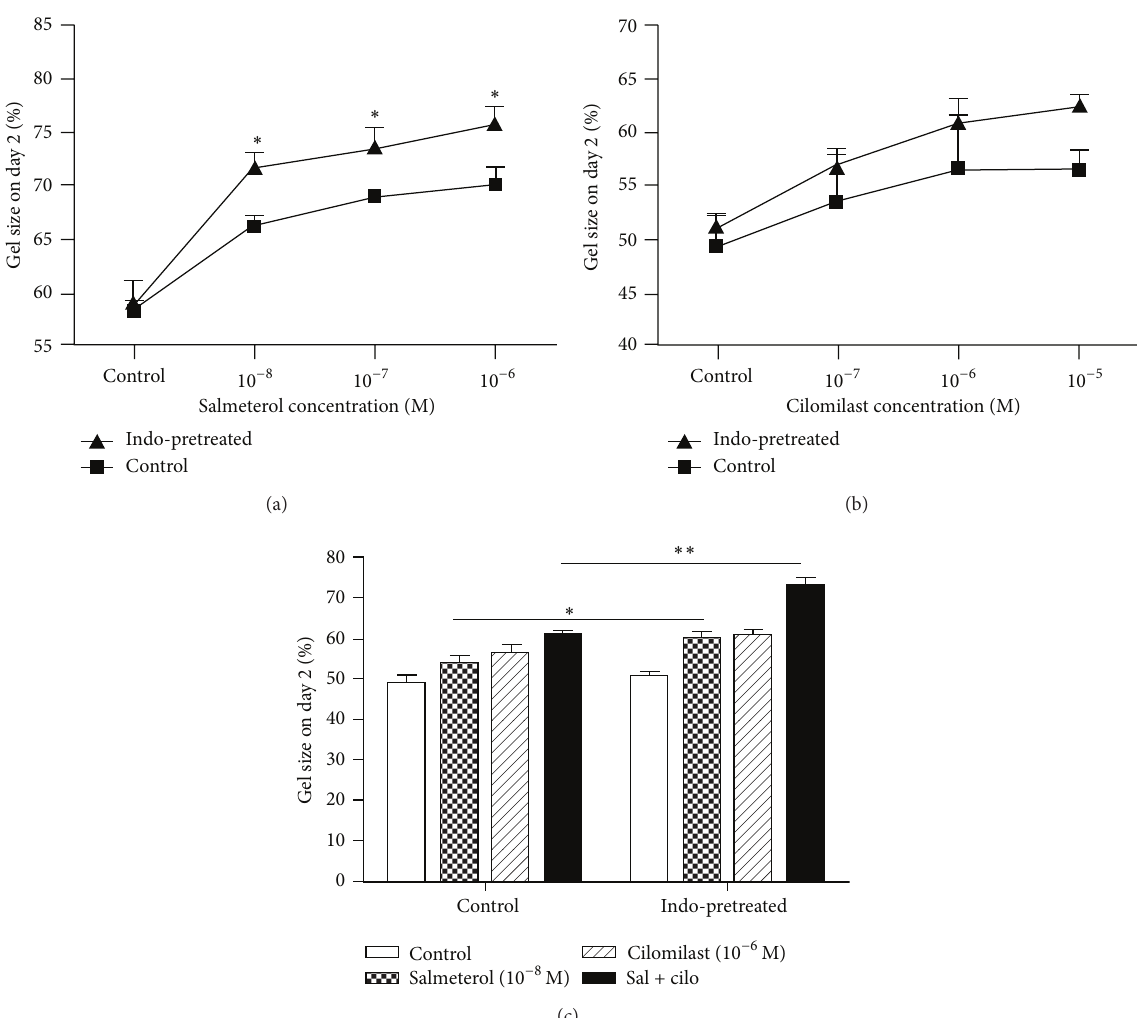
Figure 3: Indomethacin potentiates salmeterol but not cilomilast. Confluent HFL-1 cells were pretreated with SF-DMEM with or without 10 −6 M indomethacin for 24hrs. The next day, cells were cast into collagen gels as described in Section 2. (a) Indomethacin pretreatment potentiated the salmeterol effect on fibroblast-mediated collagen gel contraction. Gels were released into SF-DMEM supplemented with varying concentrations of salmeterol as indicated. Vertical axis: gel size on day 2 (%); horizontal axis: salmeterol concentrations (M). Square: cells were cultured in SF-DMEM for 24hrs prior to being cast into collagen gels; triangle: cells were pretreated with 10 −6 M indomethacin for 24 hrs prior to being cast into collagen gels. ∗ 𝑃 < 0.05 compared to control at each time point. (b) Indomethacin pretreatment did not affect the cilomilast effect. Gels were released into SF-DMEM containing varying concentrations of cilomilast as indicated. Vertical axis: gel size on day 2 (%); horizontal axis: cilomilast concentrations (M). Square: cells were cultured in SF-DMEM for 24 hrs prior to being cast into collagen gels; triangle: cells were pretreated with 1 𝜇 M indomethacin for 24hrs prior to being cast into collagen gels. (c) Indomethacin further potentiated the synergistic effect of salmeterol and cilomilast added together on fibroblast-mediated collagen gel contraction. Gels were released into SF-DMEM with or without salmeterol and/or cilomilast as indicated. Vertical axis: gel size on day 2 (%); horizontal axis: reagents in the medium in which gels were floated. Open bars: cells were cultured in SF-DMEM for 24 hrs prior to being cast into collagen gels; hatched bars: cells were pretreated with 10 −6 M indomethacin for 24hrs prior to being cast into collagen gels. ∗ 𝑃 < 0.05 ; ∗∗ 𝑃 < 0.01